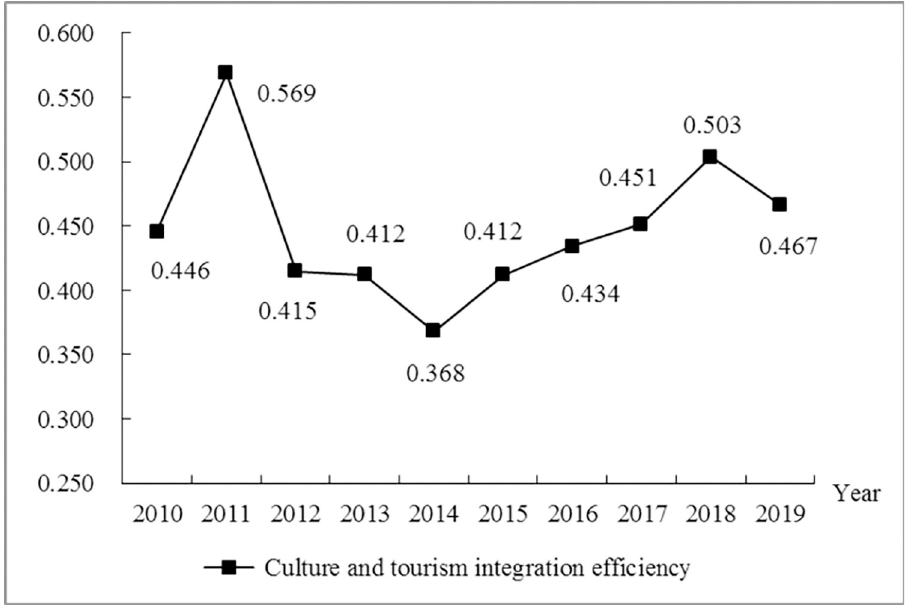
Fig 1. Temporal series characteristics of culture and tourism integration efficiency in Shandong Province from 2010 to